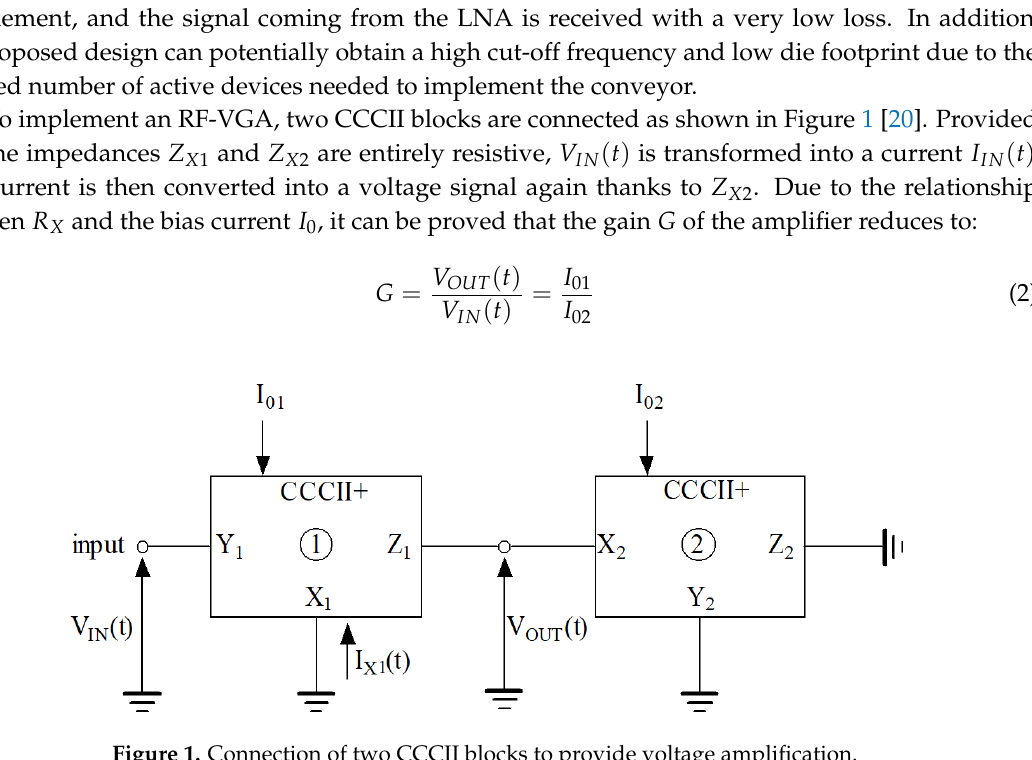
Figure 1. Connection of two CCCII blocks to provide voltage